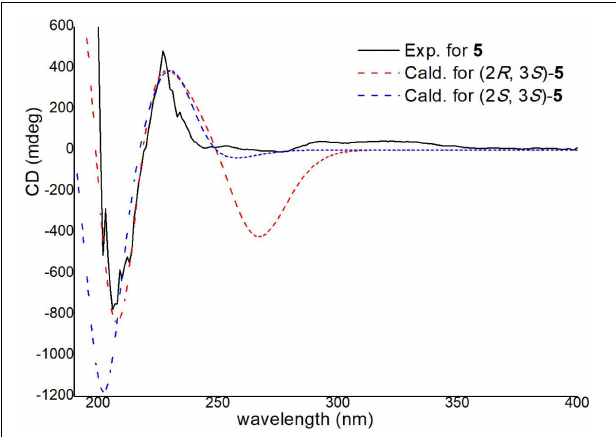
FIGURE 9 | Experimental and calculated ECD spectra of compound 5